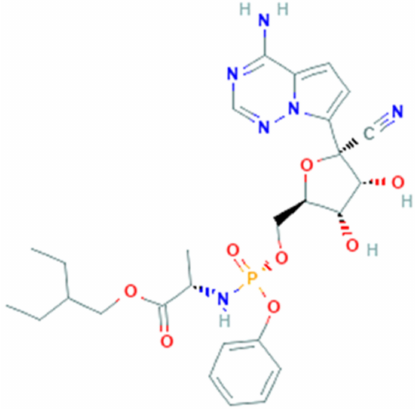
Figure 6. Chemical structure of